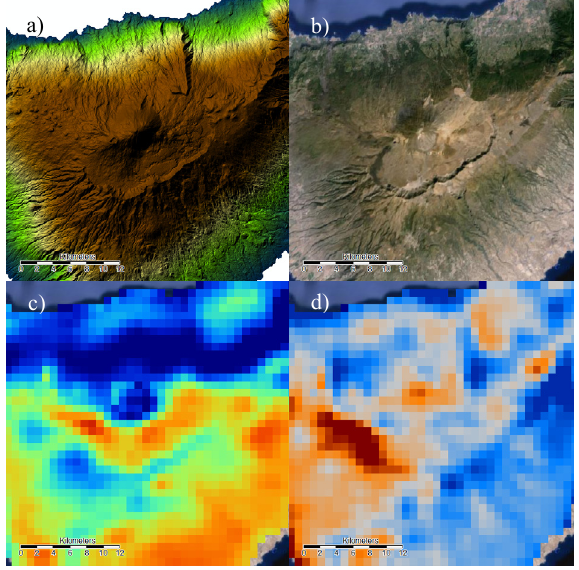
Figure 5. Tenerife subset with Mount Teide. a) SRTM DEM and analytical hill shading; b) Satellite image (Google Earth); c) Mean annual surface temperature (MAST) at 10:30; d) MAST difference between